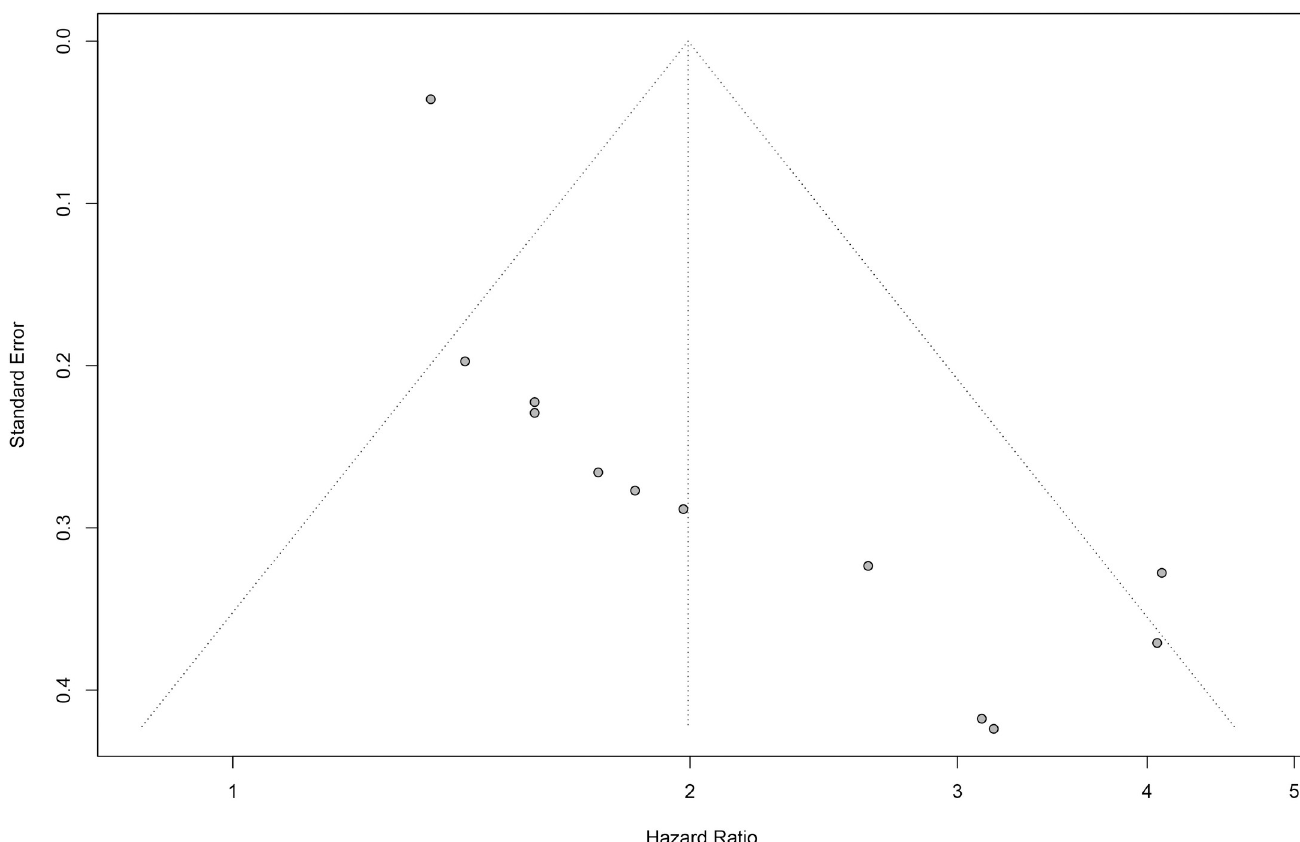
Fig 5. Funnel plot for detecting publication bias of studies